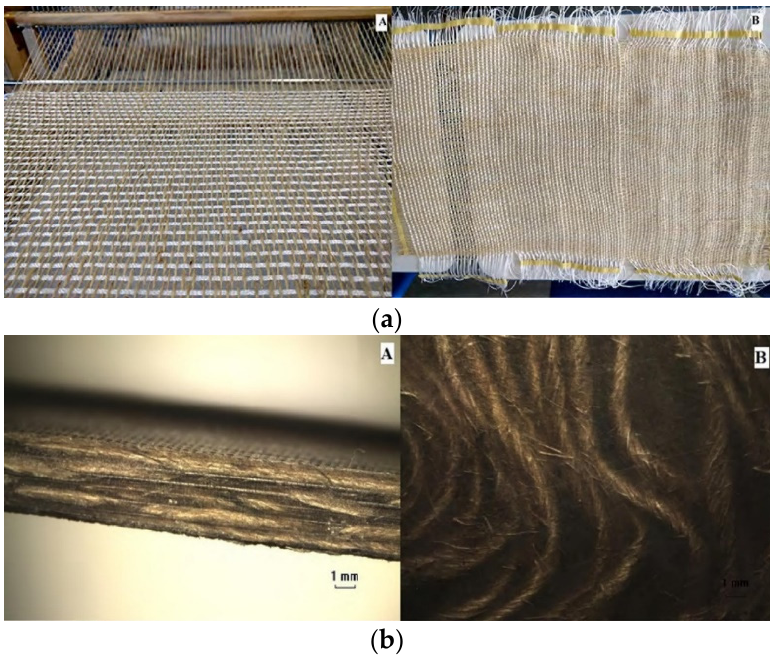
Figure 12. ( a ) Jute/PP HWF architecture and ( b ) cross-sectional optical micrographs of the laminate Adapted from Reference [53] under Creative Commons license.